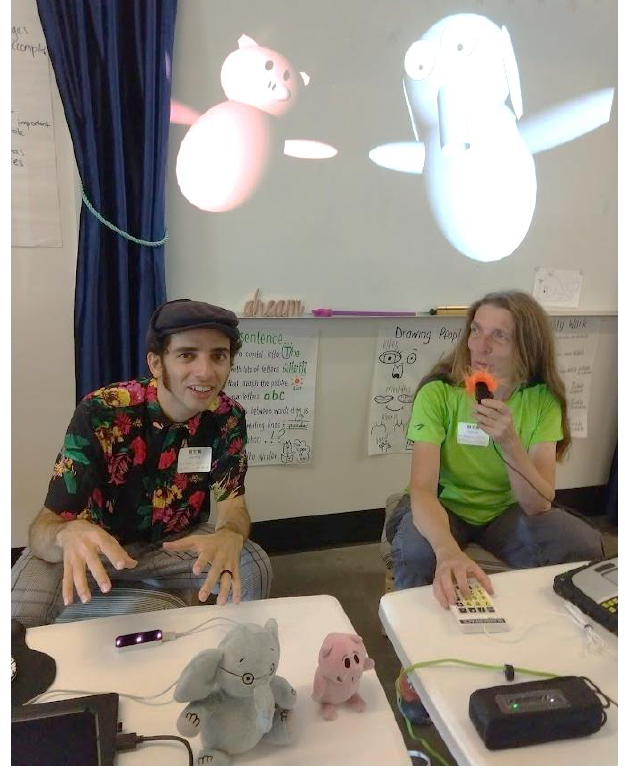
Figure 12. Jarbas and Katja preparing for first graders presentation at High Tech Elementary, San Diego. Hugo Jácome modeled these two Katjas’s puppets which were used in the Pure Data/GEM prototype version of the Virtual Puppet system ( Figure 13